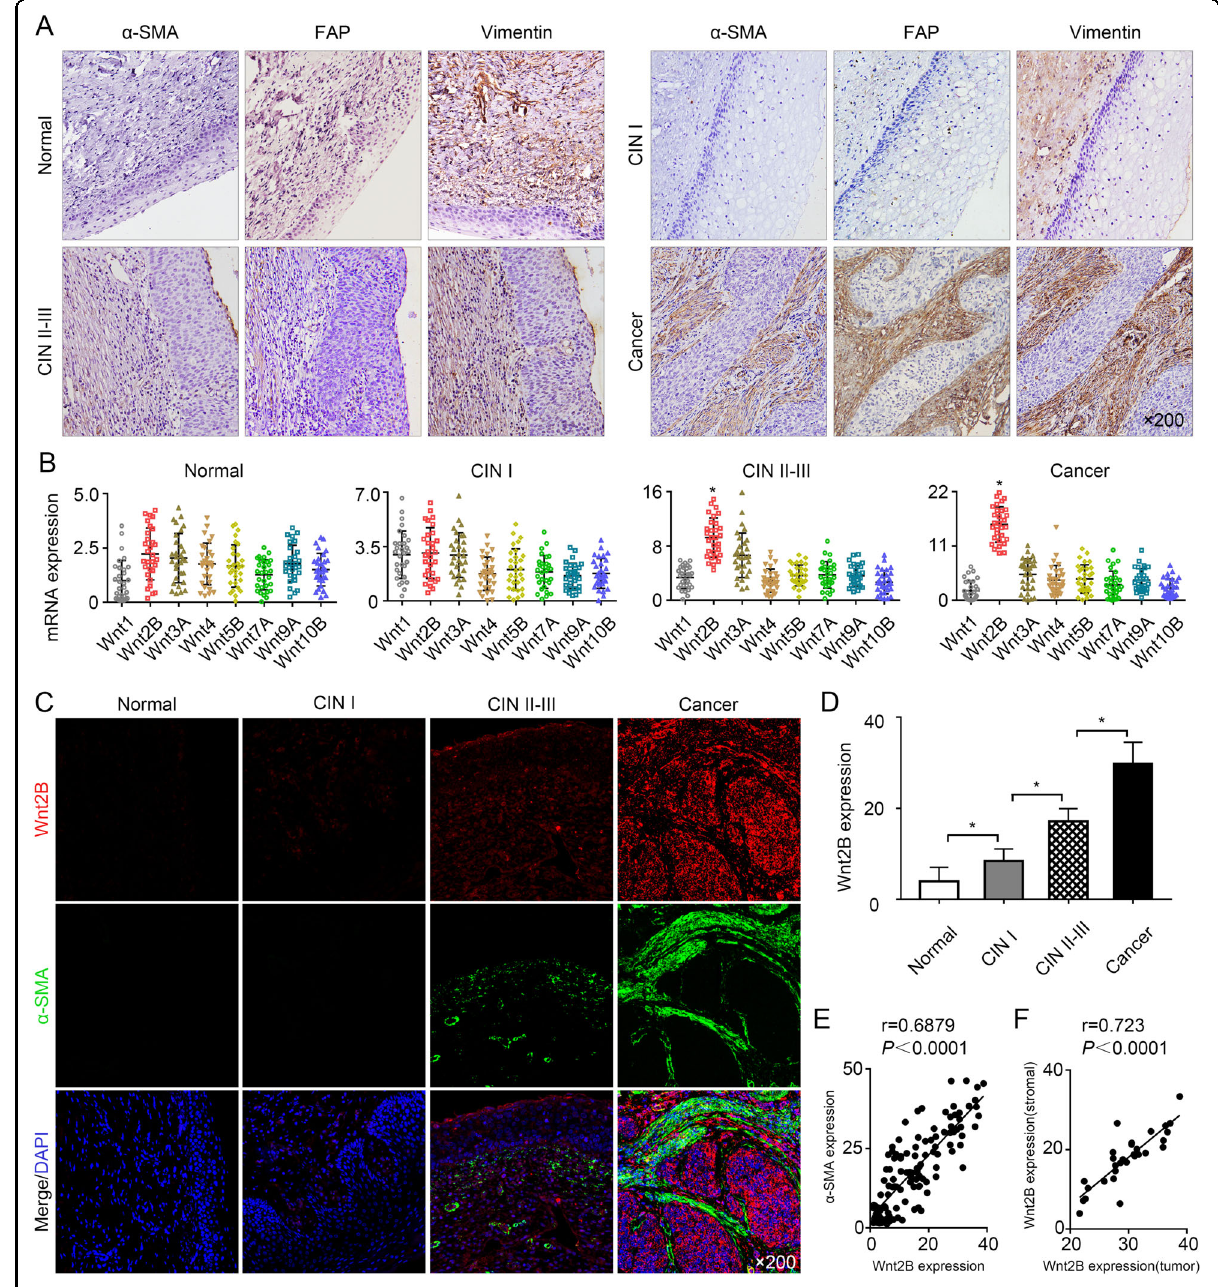
Fig. 1 Wnt2B upregulation correlates with increased CAF numbers during cervical carcinogenesis. A α -SMA, FAP, and Vimentin immunostaining of cervical tissue samples ( n = 10 normal cervix; n = 17 CIN I; n = 32 CIN II – III; n = 32 CC) at ×200 magni fi cation. B Quantitative PCR analysis for Wnt expression in the four groups ( n = 30 per group). C Cervical specimens were stained with Wnt2B (red), α -SMA (green), and DAPI (blue) for confocal microscopy at ×200 magni fi cation. D Wnt2B expression levels were analyzed in the four groups. E Correlation of Wnt2B and α - SMA expression with CAF accumulation. F Correlation of Wnt2B expression between tumor and stromal. Error bars represent the mean ± SD of three independent experiments. * P <